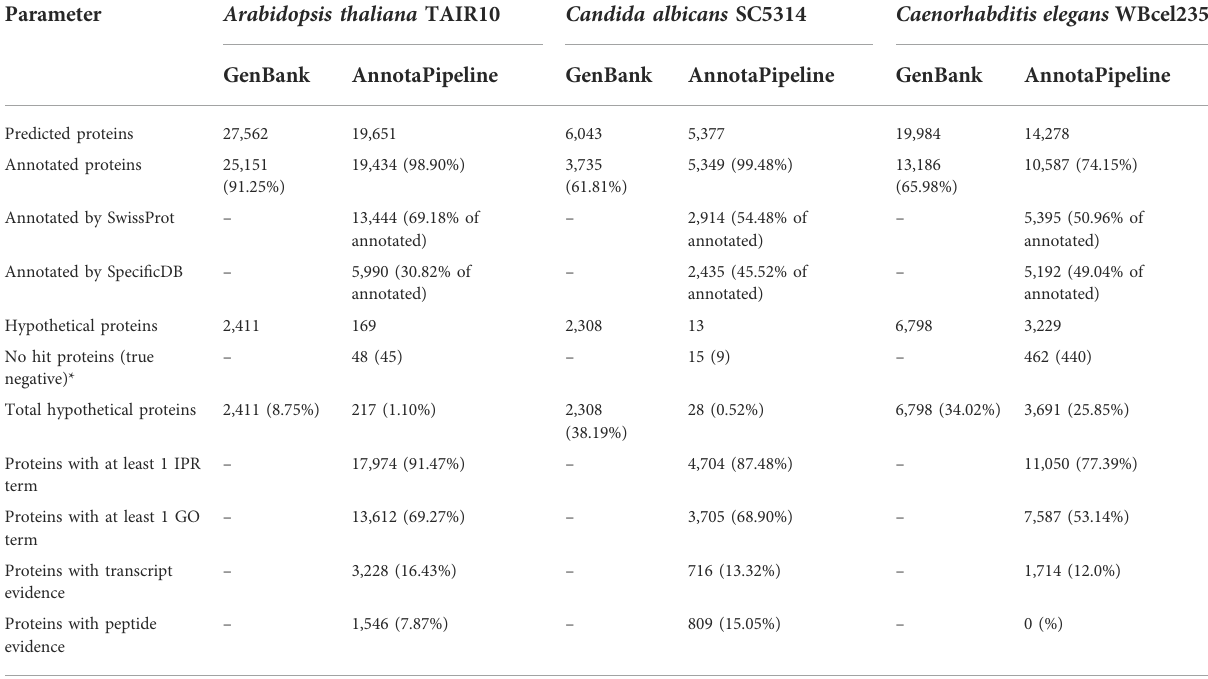
TABLE 1 Summary of AnnotaPipeline annotations, functional annotations, and experimental evidence results for different model